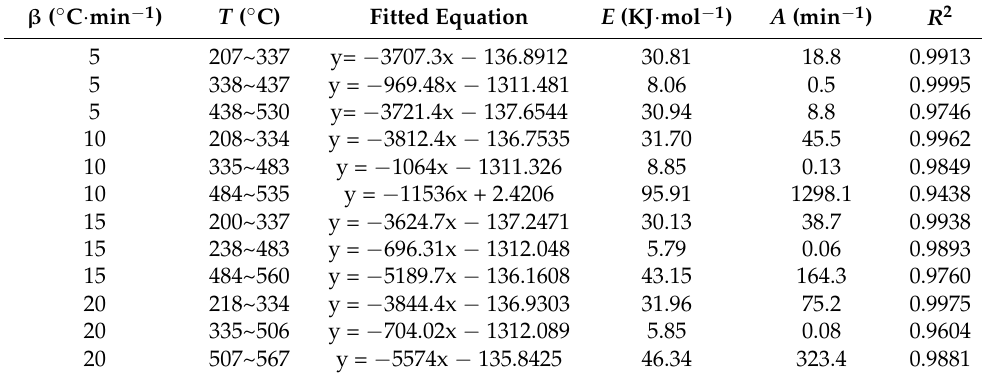
Table 4. The thermal decomposition kinetic parameters of the chicken manure in the presence of air